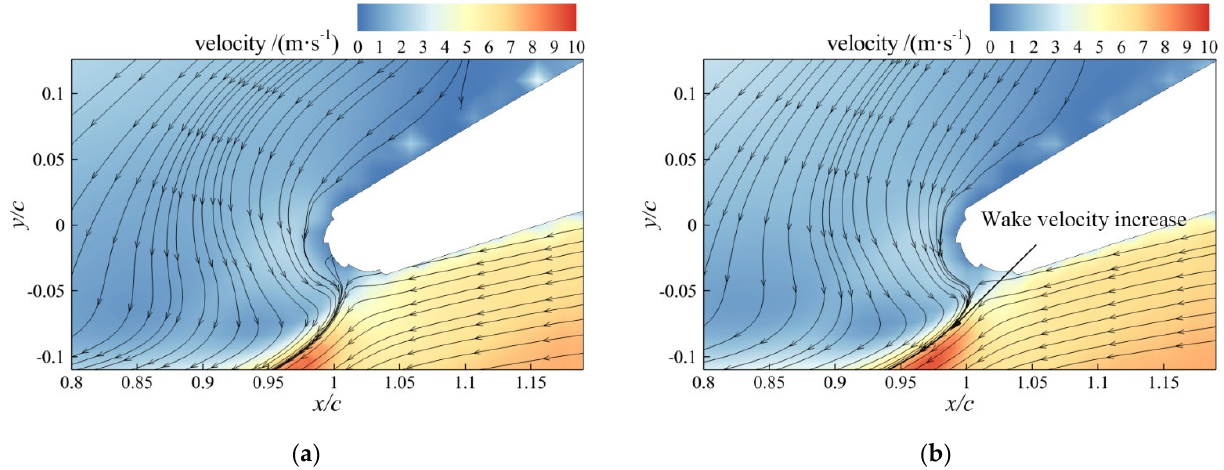
Figure 18. Comparison of velocity cloud and streamline diagrams at different blowing ratios ( U ∞ = 8 m/s, AoA = 20°). ( a ) 1:1:1 Blowing ratio. ( b ) 3:1:2 Blowing ratio.